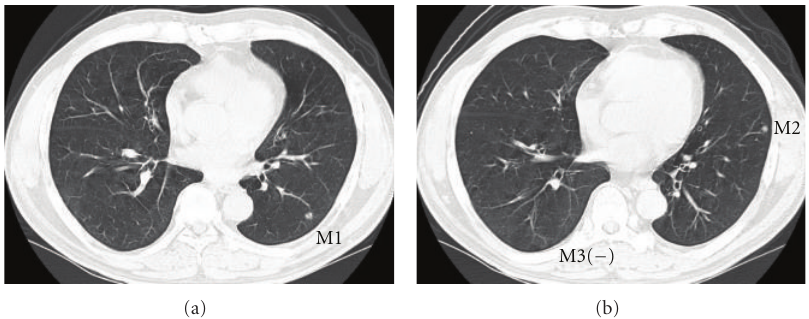
Figure 6: After two courses of adjuvant chemotherapy showing good response to all metastases. Note M3 was not recognizable.